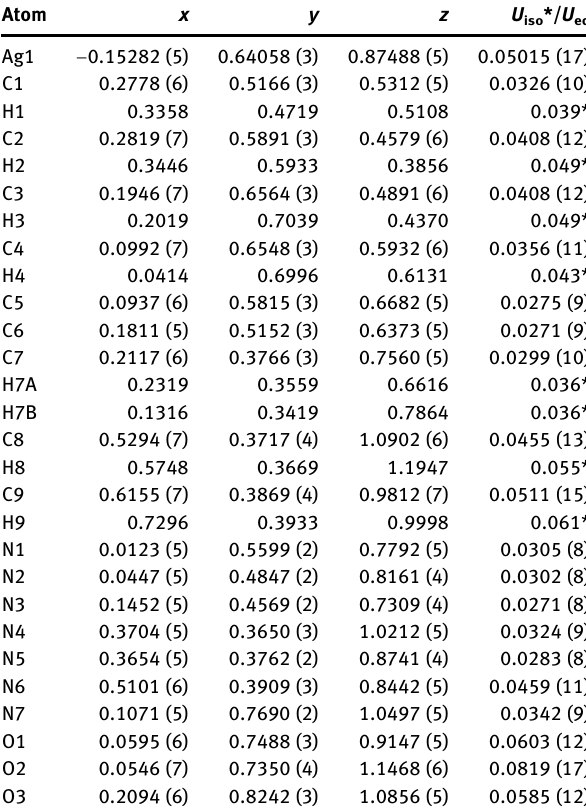
Table  : Fractional atomic coordinates and isotropic or equivalent isotropic displacement parameters (Å 